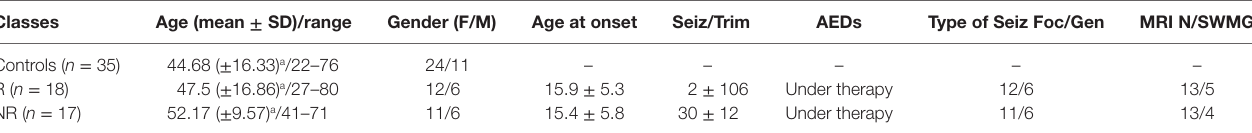
TaBle 1 | Summary of the patients enrolled in the study: healthy controls, responders (R), and non-responders (NR) under therapy with AEDs.